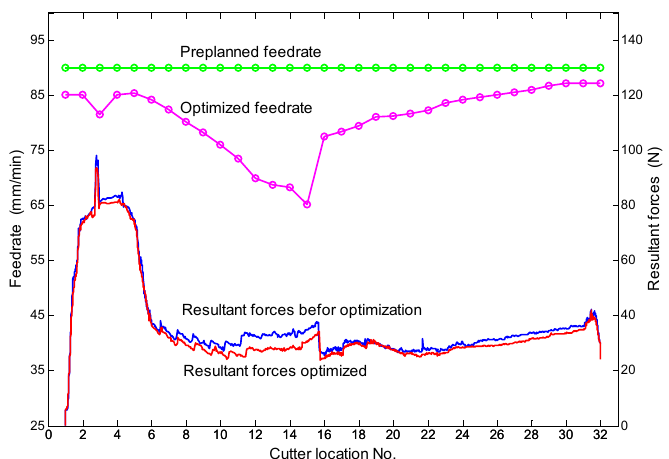
Figure 9. Comparisons of the feed rates and the cutting forces before and after optimization.